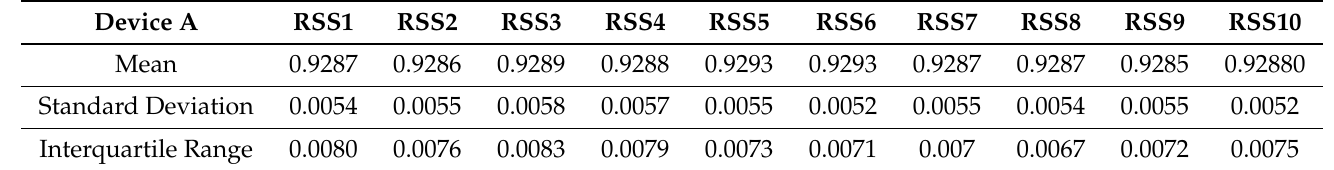
Table 4. Statistical overview of mean, standard deviation and interquartile between groups for Device A.